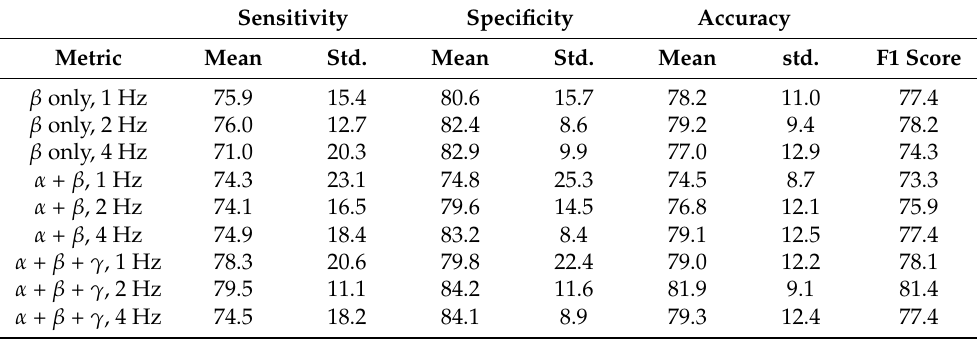
Table 2. Results for experiment II using SVM. The numbers given are percentage.